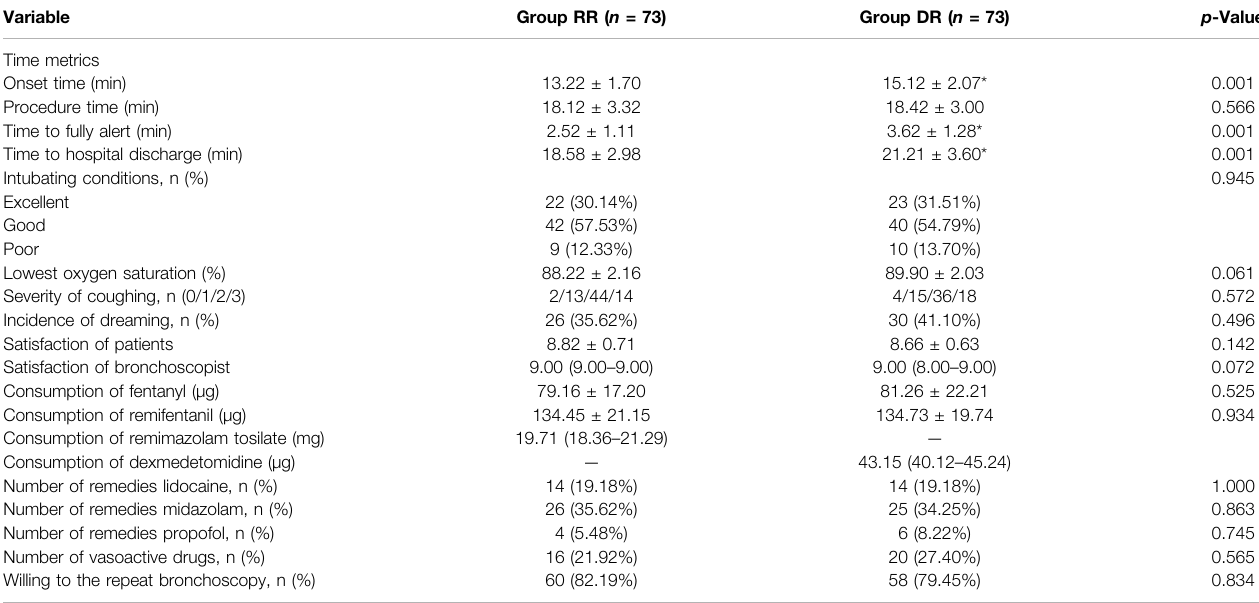
TABLE 3 | Difference of second outcomes between the two groups. Variable Group RR ( n = 73)